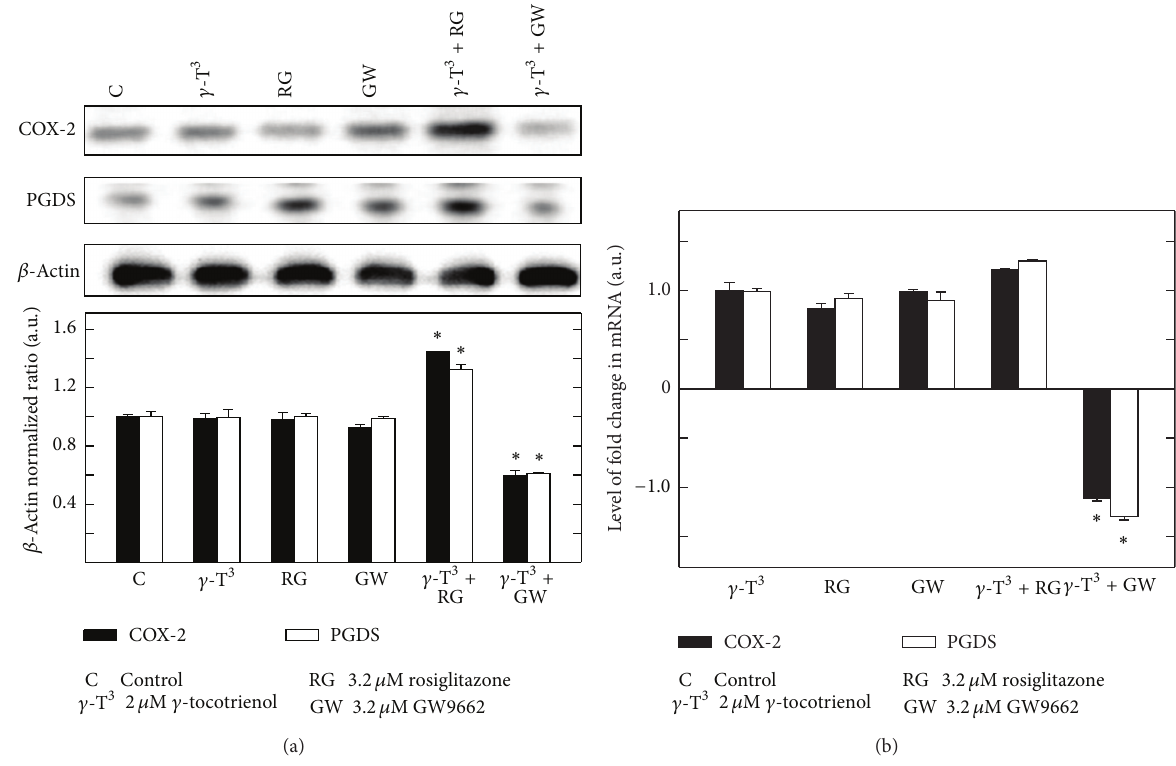
Figure 5: (a) Western blot and (b) qRT-PCR analysis to determine effect of 𝛾 -tocotrienol, rosiglitazone, and GW9662 given alone or in combination on levels of COX-2 and PGDS in +SA cells. For Western blot analysis, +SA cells were plated at 1×1 0 6 cells/100 mm culture dish and treated with control or treatment media for 4-day incubation period. Afterwards, whole cell lysates were prepared from each treatment groupforsubsequentseparationbypolyacrylamidegelelectrophoresis(50 𝜇 g/lane)followedbyWesternblotanalysis.Scanningdensitometric analysiswasperformedonalltheblotsdoneintriplicateandtheintegratedopticaldensityofeachbondwasnormalizedwithcorresponding 𝛽 - actin, as shown in bar graphs below their respective Western blot images. Vertical bars in the graphs indicate the normalized integrated optical density of bands visualized in each lane ± SEM (arbitrary unit). For qRT-PCR analysis, +SA cells were plated at a density of 2 × 1 0 3 cells/well (3 replicates per group) in 6-well plates and treated with control or treatment media for a 4-day culture period. Total RNA was extracted and first-strand cDNA was generated from total RNA for each sample according to the manufacturer’s instructions. COX-2, PGDS, and GAPDH were measured using Taqman technology. Changes in mRNA levels of COX-2 and PGDS were normalized to mRNA level of GAPDH and represented as bar graph. Vertical bars indicate the normalized C t value ± SEM (Arbitrary Unit) in each treatment group. ∗ 𝑃 < 0.05 as compared with vehicle-treated